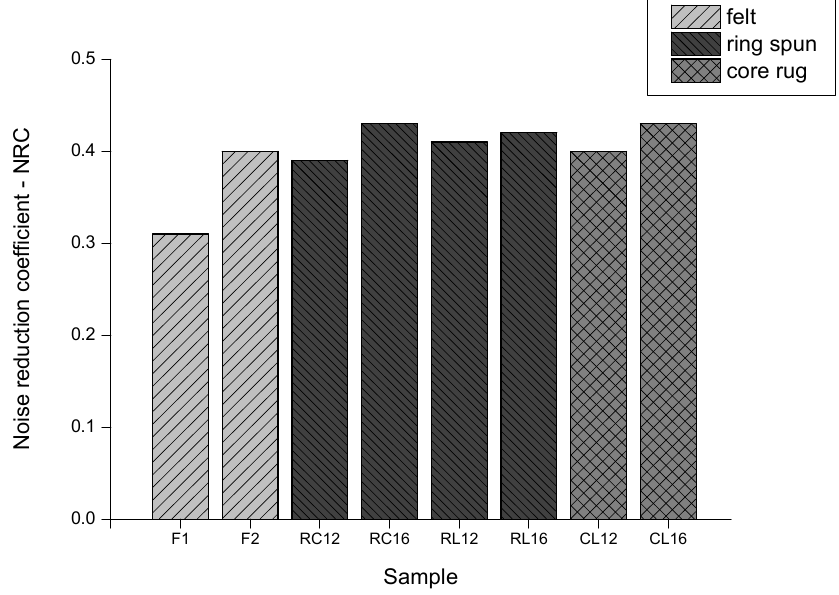
Figure 10. NRC value for felt and tufted fabrics.